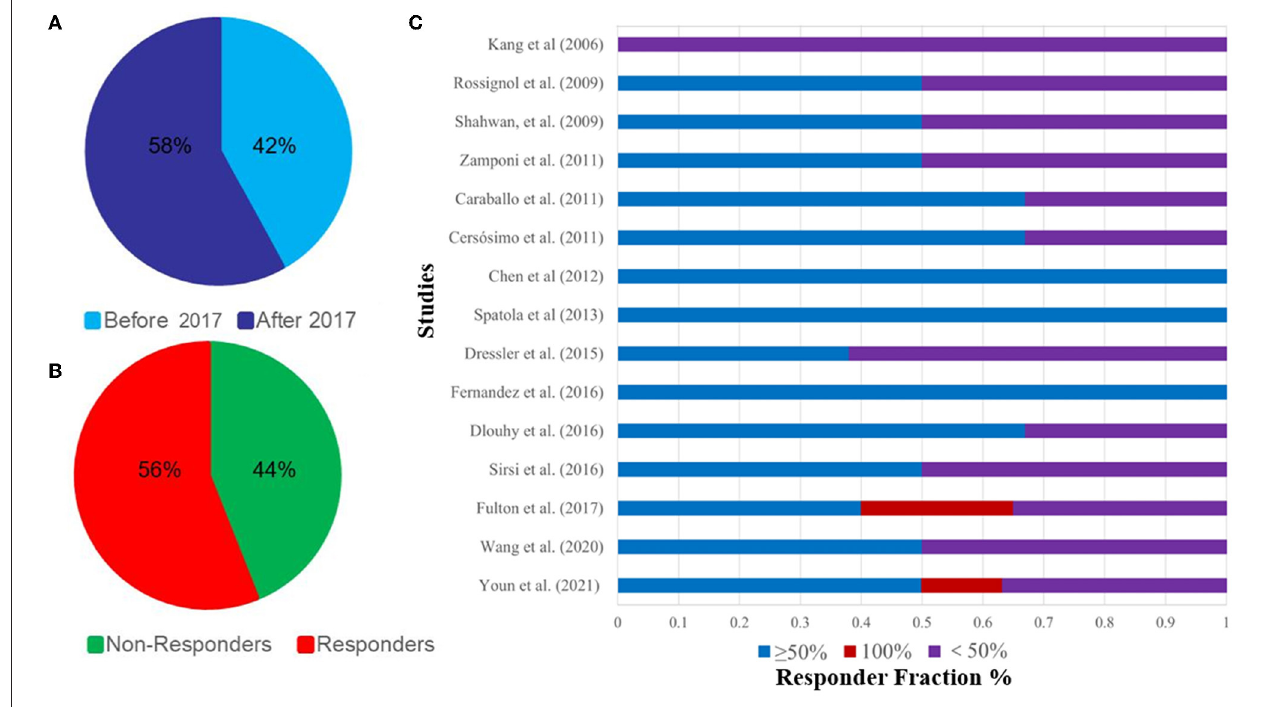
FIGURE 4 | (A) , Percentage of DS patients receiving VNS before and after 2017; (B) , 15 articles on the epilepsy control rate of VNS in the treatment of DS; (C) , Percentage of responders and non-responders to DS receiving